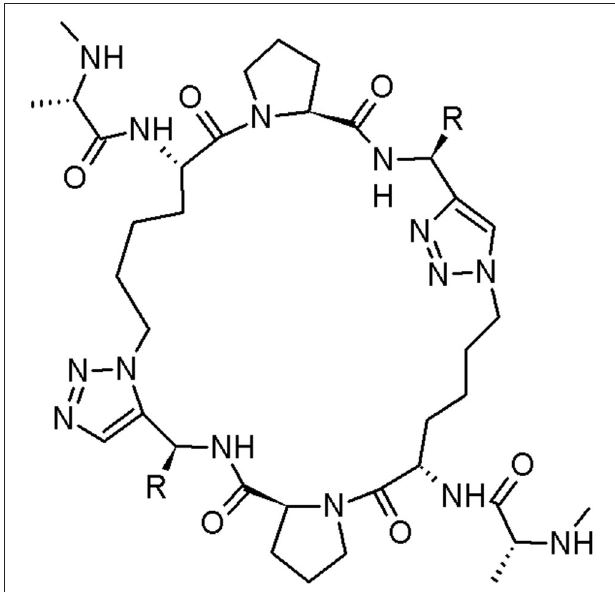
FIGURE 6 | The cyclic peptidomimetic of Smac (structure 2 : R = phenyl; structure 3 : R = benzyl) (Sun et al.,